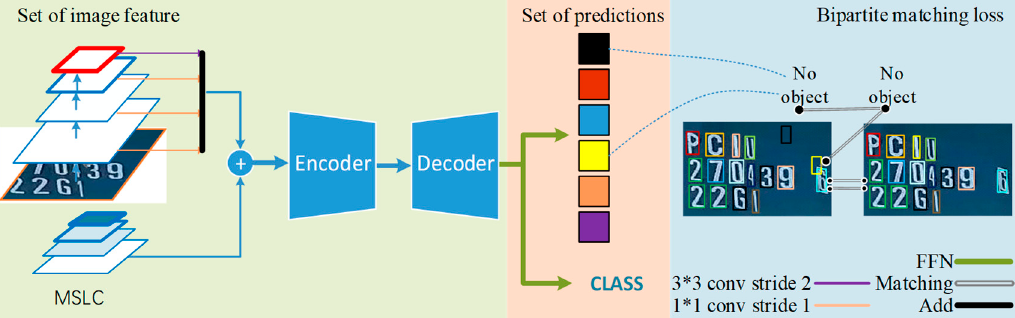
Figure 1. Container characters recognition framework based on the improved DETR framework.